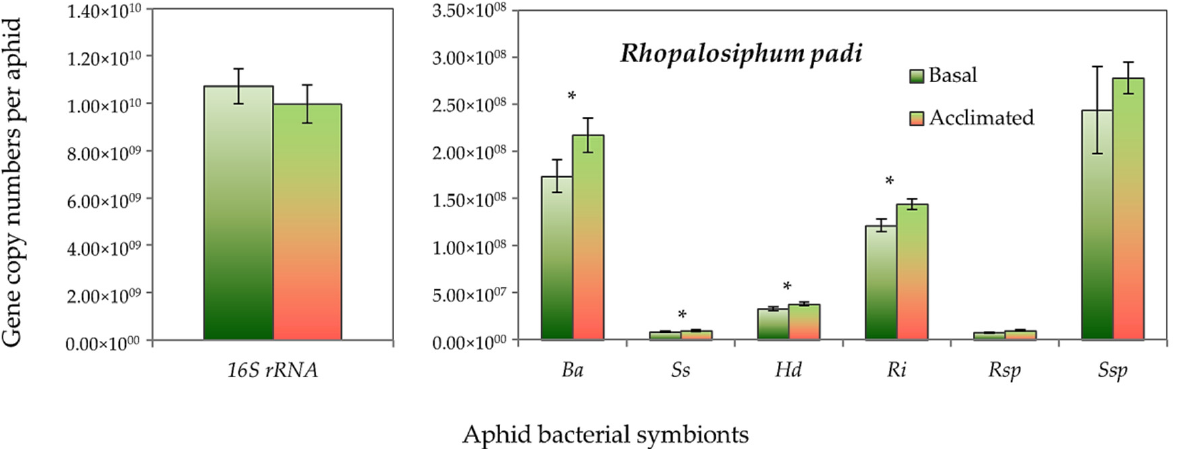
Figure 5. Abundance (mean gene copy numbers ± SD; n = 99) of bacterial symbionts of Rhopalosiphum padi aphids in acclimated and basal treatments. 16S rRNA = total eubacterial r DNA gene; Ba = Buchnera aphidicola ; Ss = Serratia symbiotica ; Hd = Hamiltonella defensa ; Ri = Regiella insecticola ; Rsp = Rickettsia spp.; Ssp = Spiroplasma spp. Asterisks signify significant difference between acclimated and basal treatments (Student’s paired t -test; p ≤ 0.05).